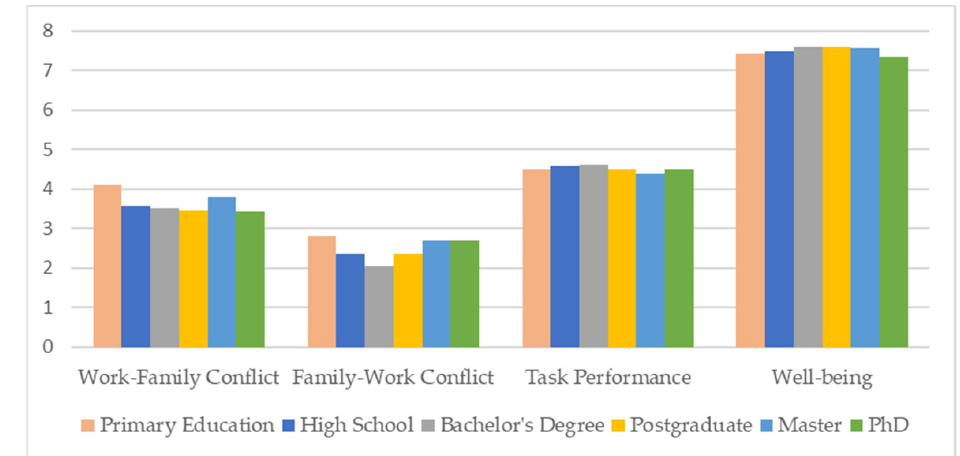
Figure 5. Distribution of variables according to academic qualifications.